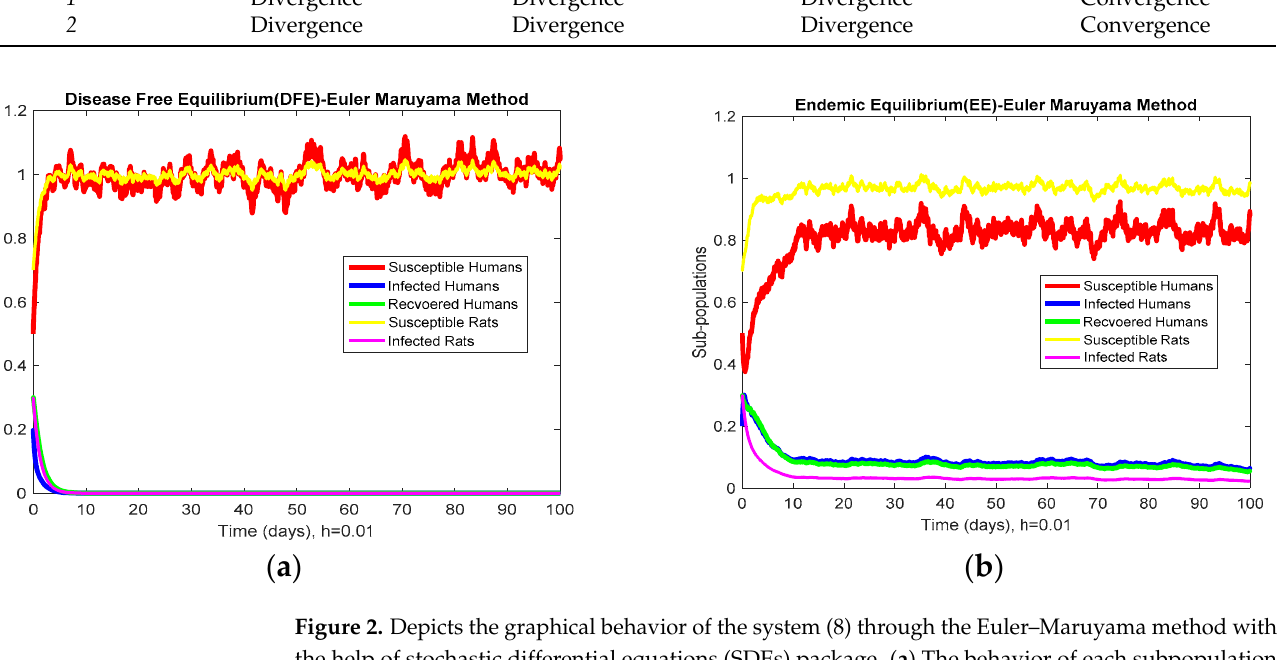
Table 3. Comparison of numerical techniques for different step sizes ‘h.